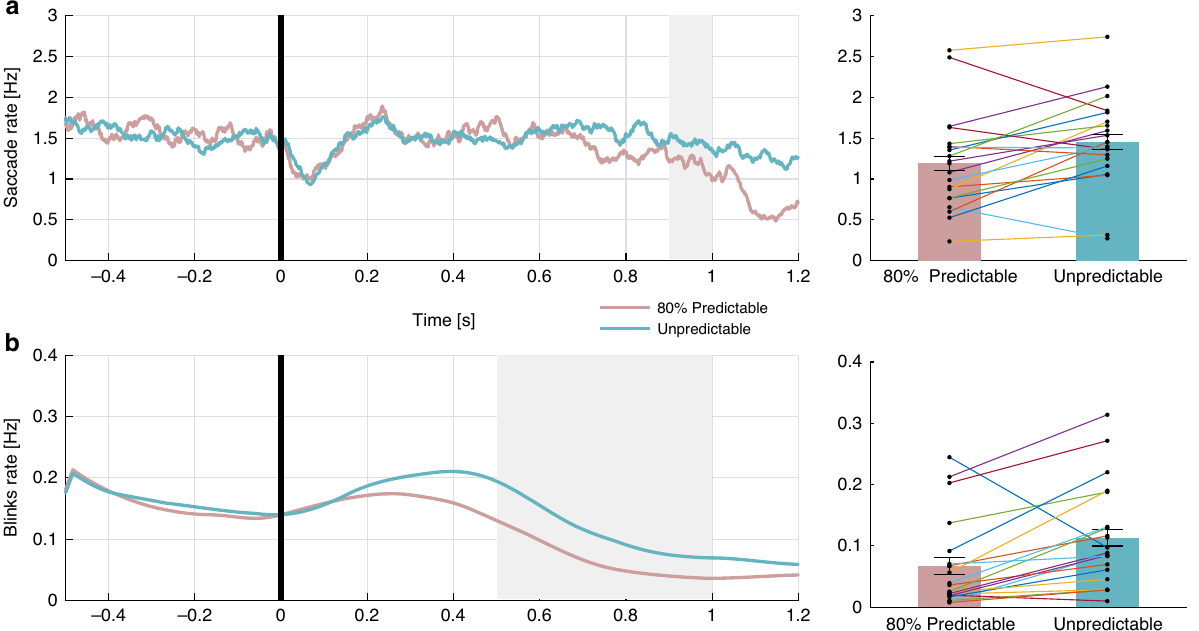
Fig. 8 Experiment 2: Saccade rates and blink rates. a Grand average saccade rate traces in the 80% predictable (pink) and the unpredictable (turquoise) conditions. The gray rectangle marks the 900 – 1000 ms post-cue analysis window. The black line represents cue offset. The bar graph to the right depicts the calculated saccade rate average within the analysis window. N = 20 participants. b Grand average of the blink rates traces in the 80% predictable (pink) and the unpredictable (turquoise) conditions. The gray rectangle marks the 500 – 1000 ms post-cue analysis window. The black line represents cue offset. The bar graph to the right represents the calculated blink rate average within the analysis window. Error bars denote ±1 standard error of the mean, corrected for within-subjects variability 60 . The colored connecting lines represent individual participants. N = 20 participants. Source data are provided as a Source Data fi